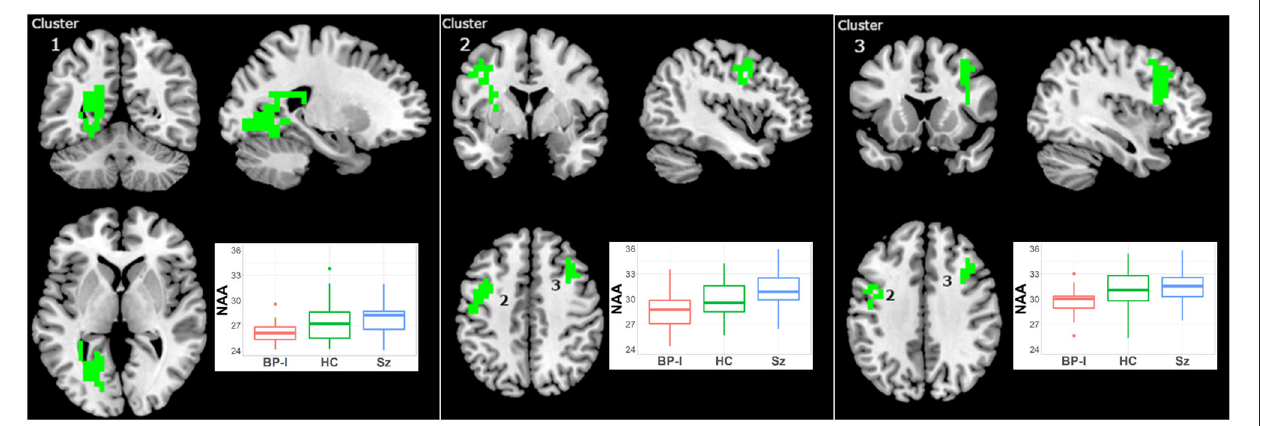
FIGURE 3 | Increased NAA in Schizophrenia (Sz) vs. Bipolar-I (BP) (healthy controls [HC] intermediate) in three clusters: (1) 114 voxels, CCLAV < 0.01, including the left lingual gyrus (29.9%) and left posterior cingulate (13.0%). (2) 61 voxels, CCLAV < 0.01, including the left precentral gyrus (34.7%%) and left middle frontal gyrus (22.1%). (3) 42 voxels, CCLAV = 0.05, including the right middle frontal gyrus (60.6%) and right precentral gyrus (10.2%). Boxplots shows weighted-average NAA cluster concentrations in institutional units.